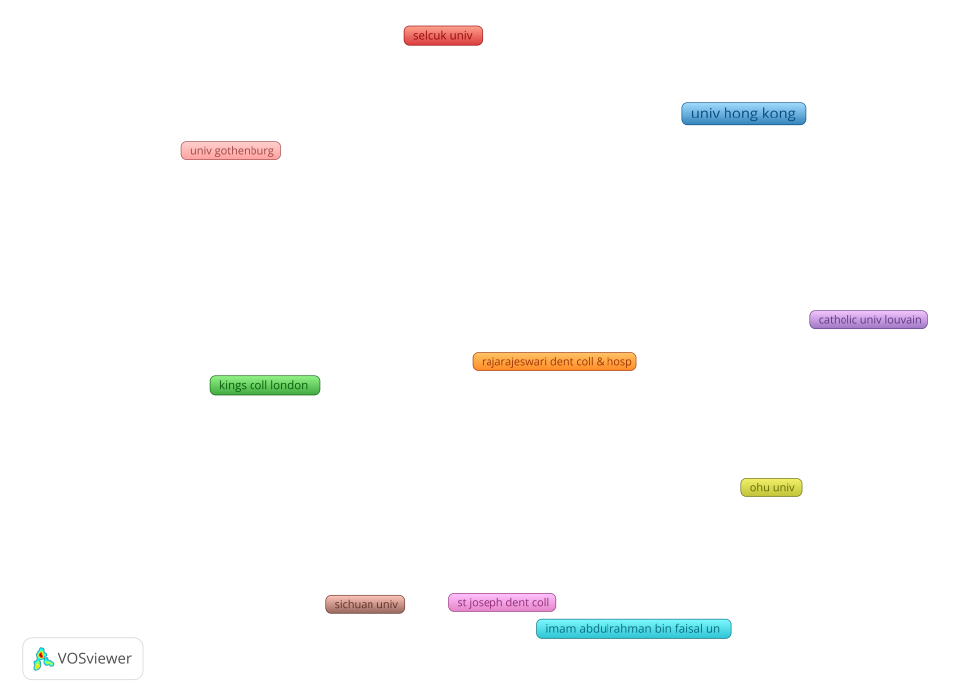
Figure 4. Scientific co-authorship by university. Source: own processing through VOSviewer. Figure 3 shows 29 countries in 11 groups. Our results indicate that the geographical Out of 123 institutions, 17 institutions had a minimum of two published documents. area that analyzed the discussed topics was rather large, but we could see strong links These were grouped in 10 clusters, as shown in Figure 4 and Table 4. between different countries in different parts of the world. The most relevant groups were the first four. They are represented by different colors: red, green, blue and yellow. England Table 4. Published documents grouped by university. Source: own processing through VOSviewer. was the European country with the most diverse collaboration teams (six documents), and with strong relationships with other countries. Outside Europe, countries such as Group 1 Australia (eight documents), Egypt (seven documents), the People’s Republic of China (11 documents), India (16 documents) and Saudi Arabia (five documents) maintained a broad range of cooperation with other countries. Authors from Brazil (seven documents), Gaziantep Univ. and Turkey (five documents) published several articles on the topic of CMCR methods, but they limited their collaboration among the researchers from their respective